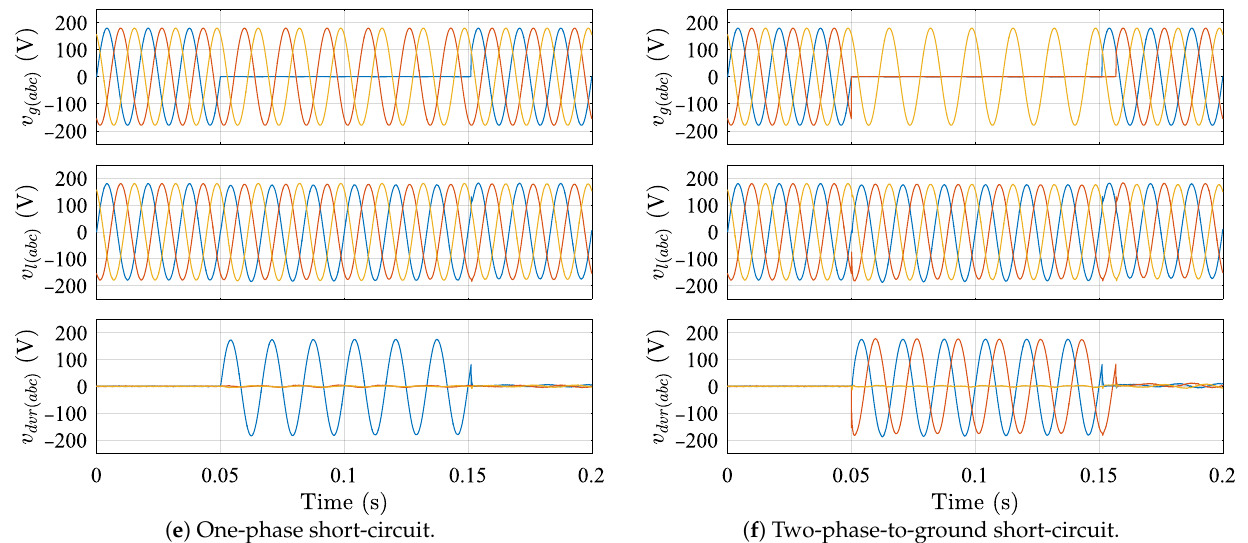
( e ) One-phase short-circuit. ( f ) Two-phase-to-ground short-circuit. Figure 10. Grid, load and conventional DVR voltages for different types of faults (simulation results).